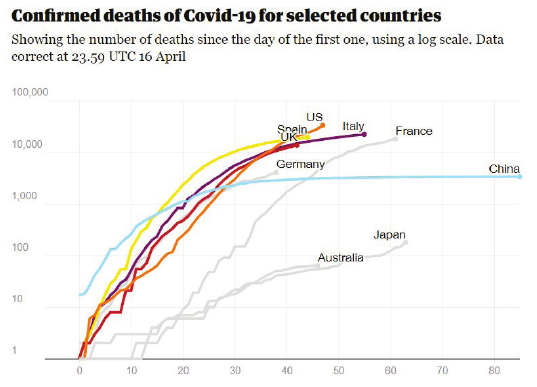
Figure 2. Confirmed deaths of COVID-19 in selected countries source Johns Hopkins